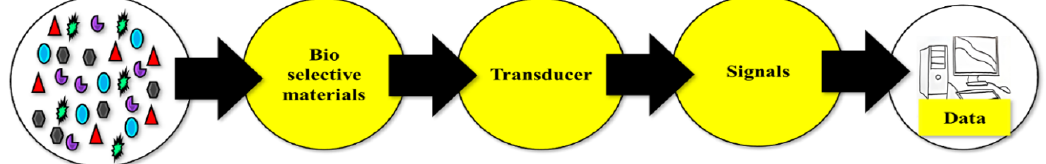
Figure 5. Sensor-based detection technologies for monitoring and assessing the presence of norovirus in shellfish. in